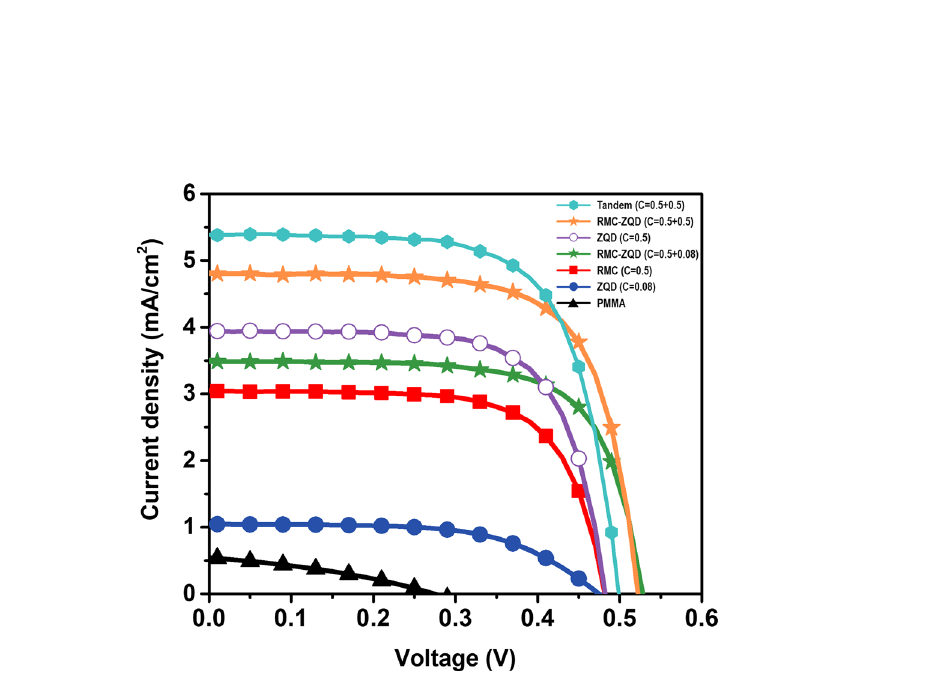
Figure 4. Current–density voltage (J–V) curves of LSC devices with various concentrations of luminophores: C = 0.5 mg/mL of RMC (red line), C = 0.5 mg/mL of ZQD (purple line), C = 0.08 mg/mL of ZQD (blue line), RMC-ZQD with 0.5 mg/mL RMC and 0.08 mg/mL ZQD (green line), RMC-ZQD with 0.5 mg/mL RMC and 0.5 mg/mL ZQD (yellow line), tandem structure RMC + ZQD with 0.5 mg/mL RMC and 0.5 mg/mL ZQD (cyan line), and C = 0.0 mg/mL PMMA (black